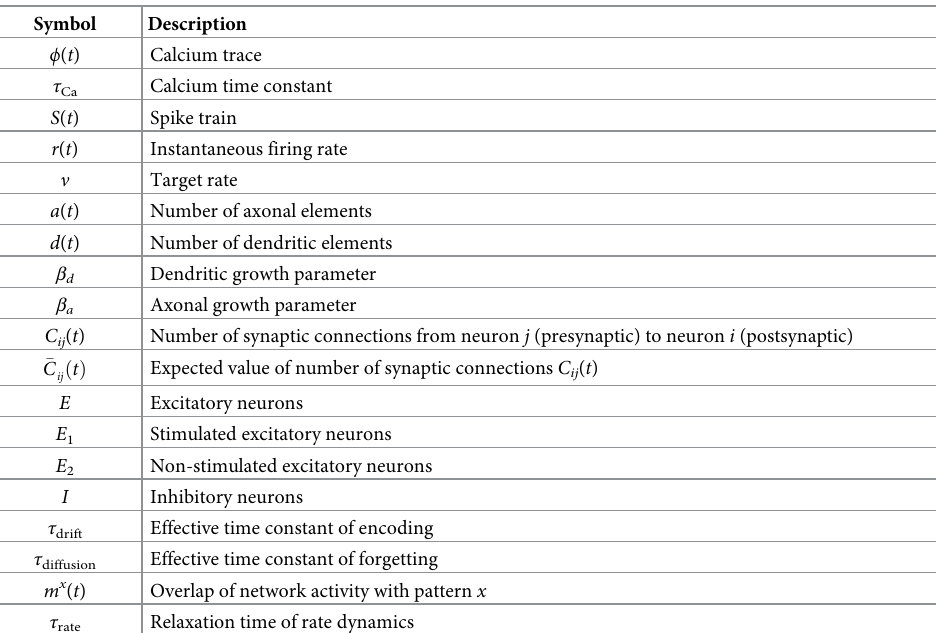
Table 1. List of